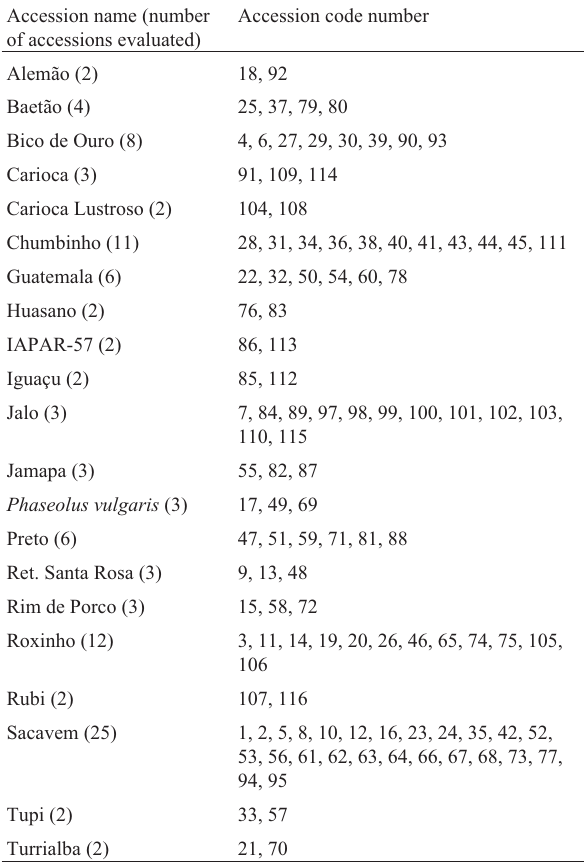
Table1 -Commonbeanaccessionsevaluatedtoidentifyduplicatesdueto similarities in the names and agromorphological descriptors. Accession name (number of accessions